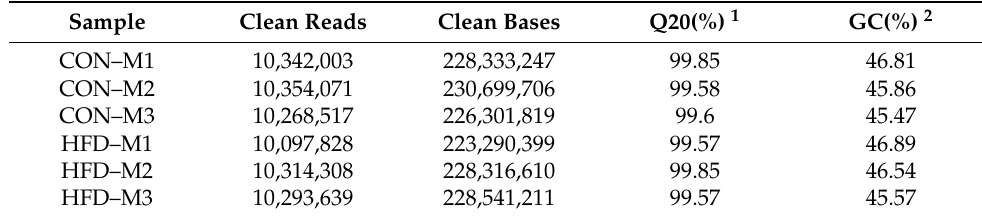
Table 1. Quality statistics for data generated from small RNA deep sequencing.